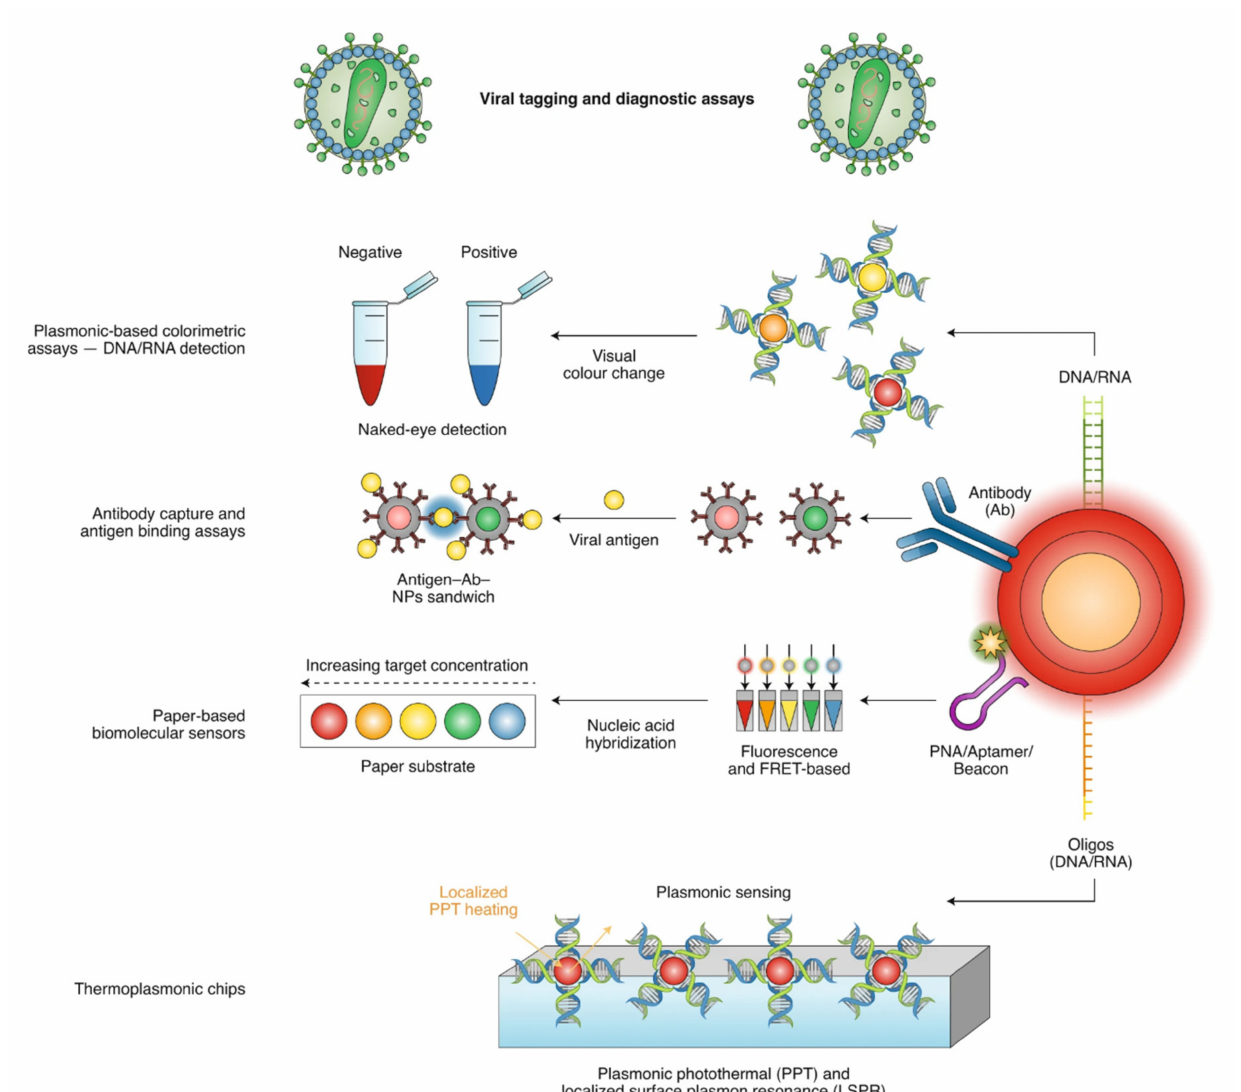
Figure 1. Nanotechnology-based detection approach for COVID-19. Adapted with permission from ref. [75]. Copyright 2020, Springer